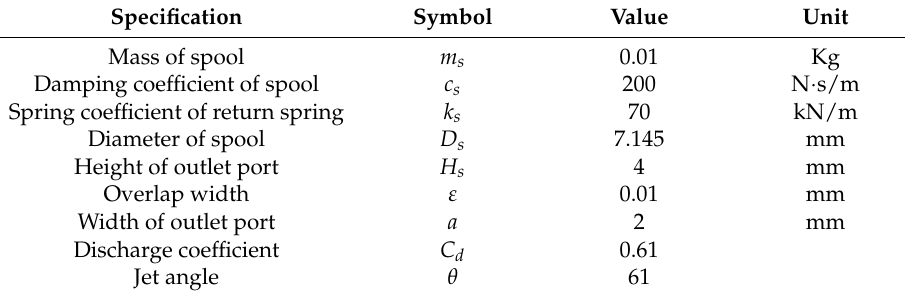
Table 2. Mechanical properties of the spool